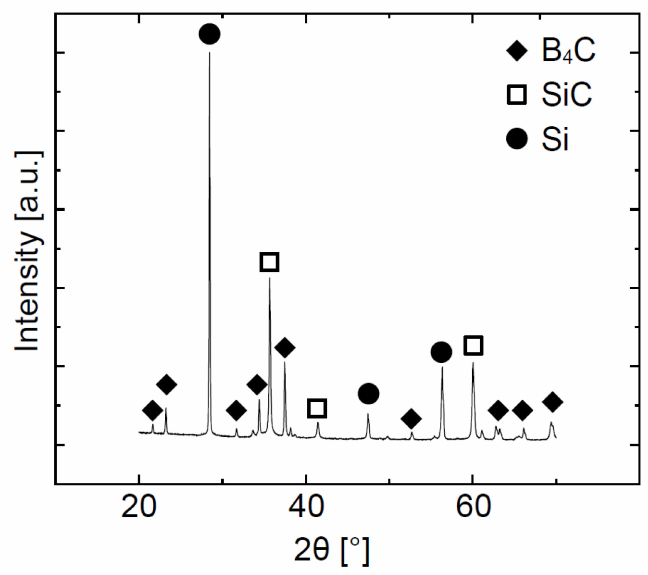
Figure 2. XRD spectrum of the infiltrated sample consisting of SiC, B 4 C, and